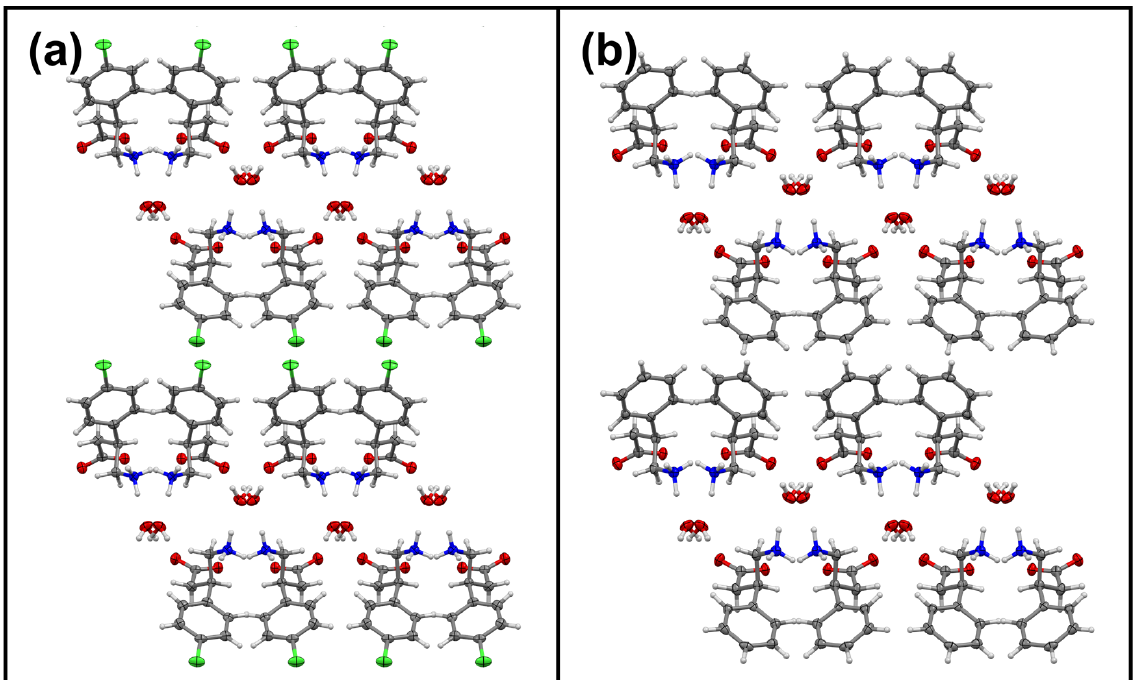
Figure 1. Structure comparison of ( a ) Baclofen • H 2 O and ( b ) Phenibut • H 2 O (re-determined—see Komisarek et al., 2021) [26], view along c-axis. Both compounds are commonly occurring intermediates during attempted crystallizations. Carbon atoms are depicted in grey, hydrogen atoms are depicted in white, oxygen atoms are depicted in red, nitrogen atoms are depicted in blue and chlorine atoms are depicted in green.